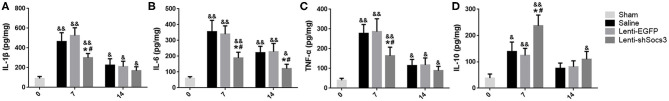
Reduced SOCS3 expression ameliorates the inflammatory microenvironment. The levels of inflammatory cytokines were detected by ELISA. The production of IL-1β (A), IL-6 (B), and TNF-α (C) were significantly reduced in the Lenti-shSOCS3 group at 7 and 14 days post-ICH. In contrast, the expression of IL-10 (D) was significantly elevated in the Lenti-shSOCS3 group compared with the Lenti-EGFP and saline groups at 7 days post-ICH. Data are presented as mean ± SD (n = 4 mice per group). &P < 0.05 (&&P < 0.01) vs. sham group, *P < 0.05 vs. saline group, #P < 0.05 vs. Lenti-EGFP group.